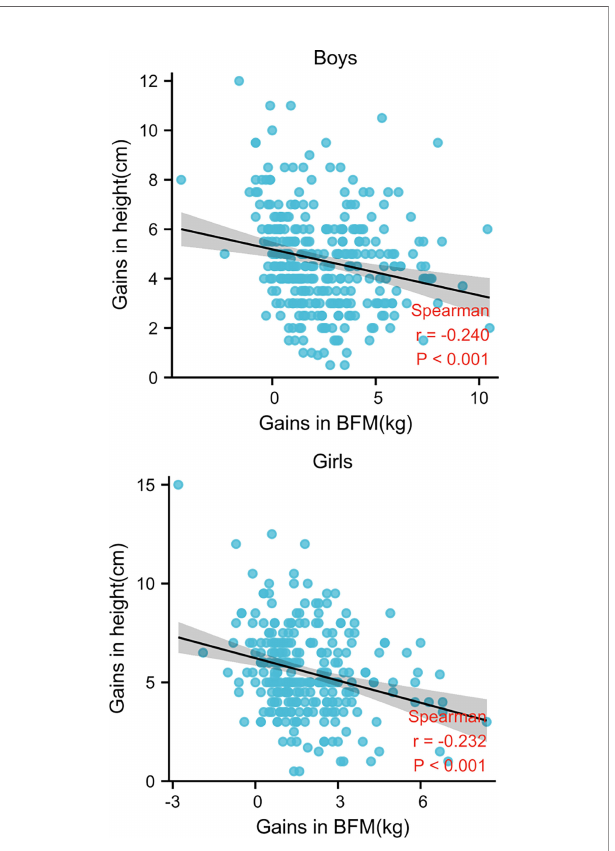
FIGURE 3 | Spearman ’ s correlation between gains in height and BFM in both